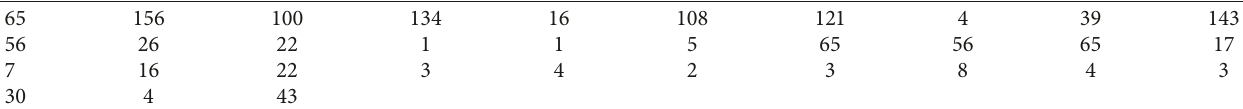
Table 2: Survival times of acute myelogenous leukaemia data.